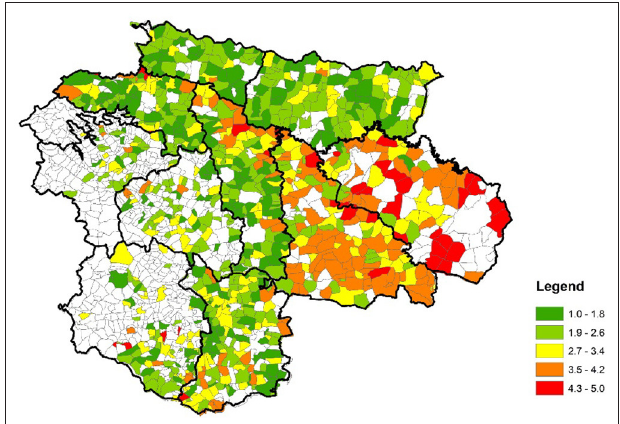
FIGURE 10 | Overall drinking water sustainability